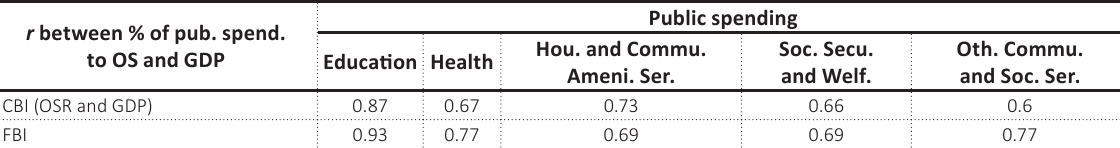
Source: Based on calculations of Tables 6 and 7.